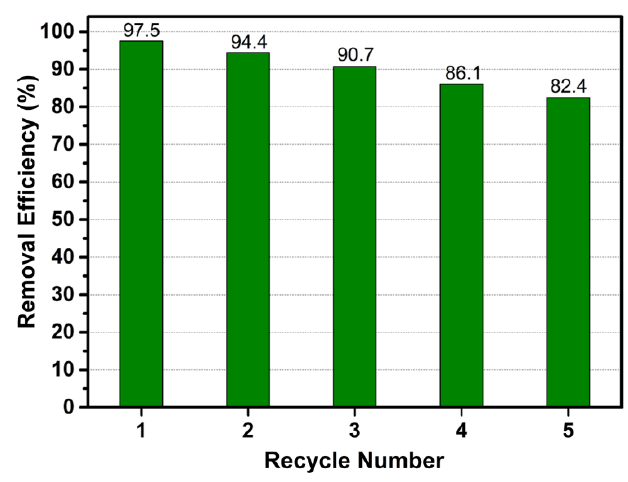
Figure 9. The regeneration efficiency of CM-ATP in column operation.